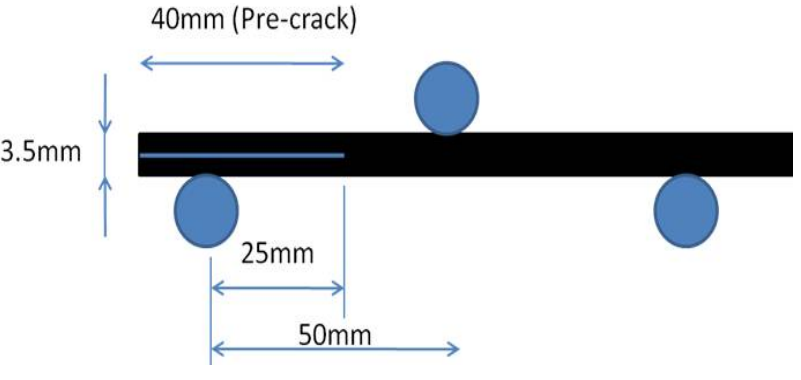
Figure 13. Sample geometry for end notch flexure double (ENF) fracture toughness